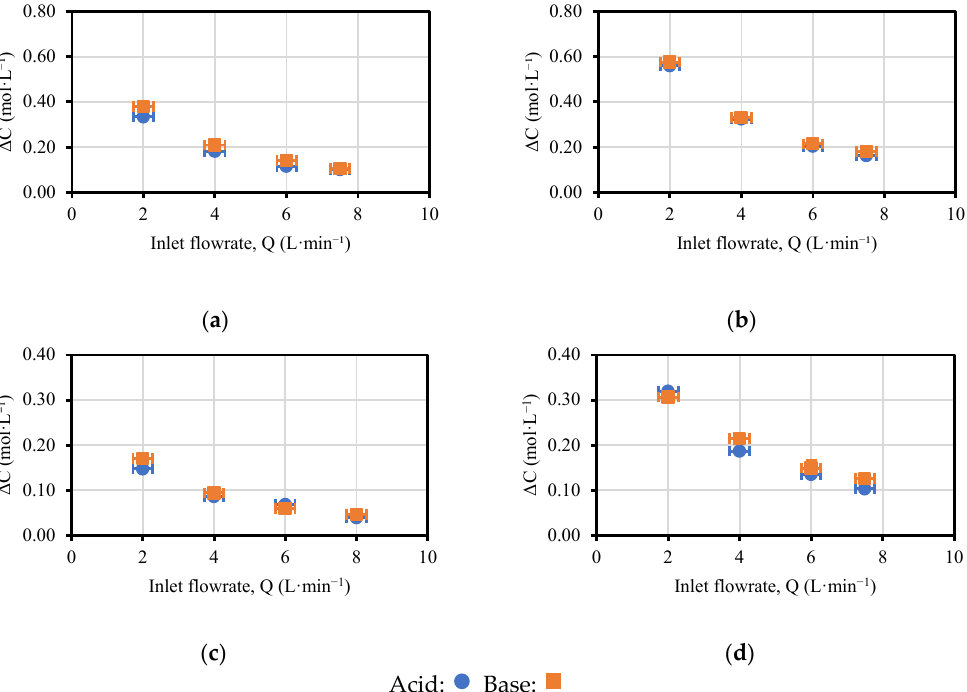
Figure 3. Values of concentration variation versus feed flowrate: ( a ) T ‐ 200 ‐ I; ( b ) T ‐ 400 ‐ I; ( c ) T ‐ 200 ‐ F; ( d ) T ‐ 400 ‐ F. The associated errors to the variation in the acid and base concentrations (vertical error bars), estimated via acid–base titrations, are below 3% and cannot be visualized in practice in the figure.